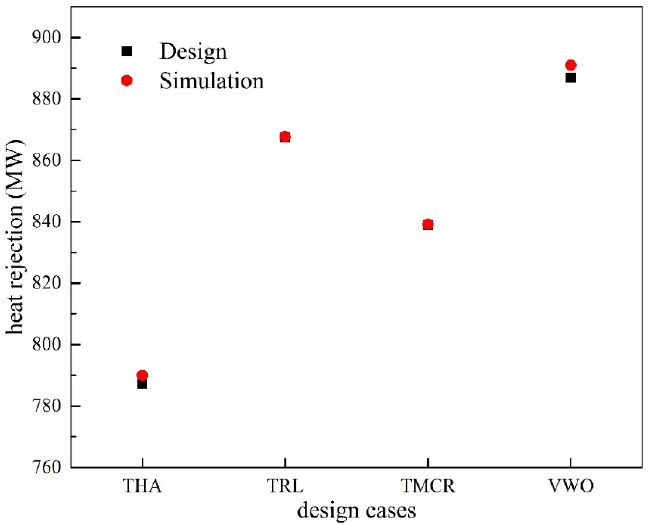
Figure 4. Design and simulated heat rejection of a 2 × 300 MW direct dry cooling power generating unit under several operating conditions.